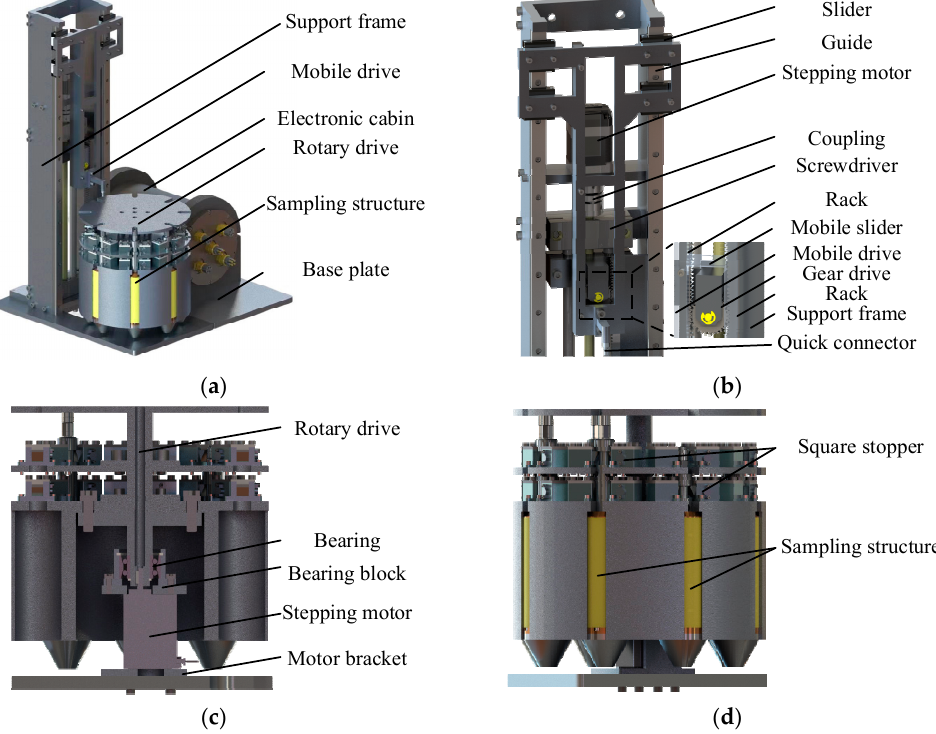
Figure 2. ( a ) The multipoint sampler; ( b ) The transmission route of mobile stepping motor; ( c ) The transmission route of rotary stepping motor; ( d ) The sampling structure location method.